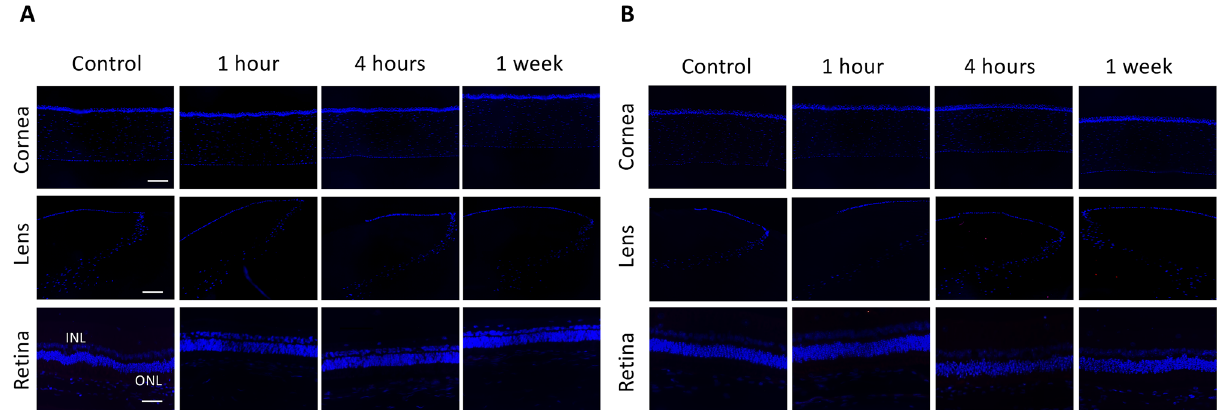
Figure 7. There was no expression of CD11b ( A ) and HSP-47 ( B ) in corneas, lens epithelium and retinas at different time points. IPL: inner plexiform layer; ONL: outer nuclear layer. Nuclei were counterstained with DAPI (blue). Scale bar 100